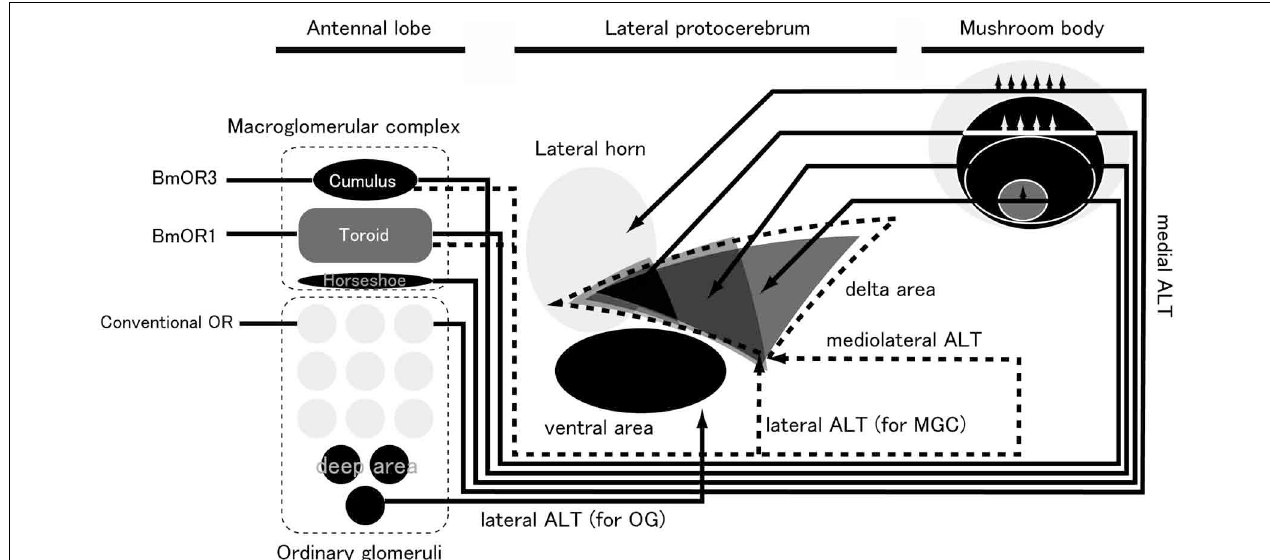
FIGURE 5 | Pheromone-processing pathway in the sensory system of B . mori . ALT, antennal lobe tract; MGC, macroglomerular complex; OG, ordinary glomeruli. (modified from Namiki et al., 2013).